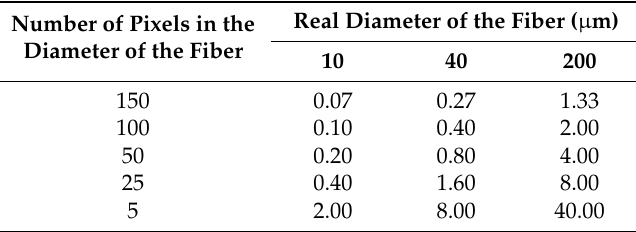
Table 3. Unit pixel length with the number of pixels and the real diameter of the